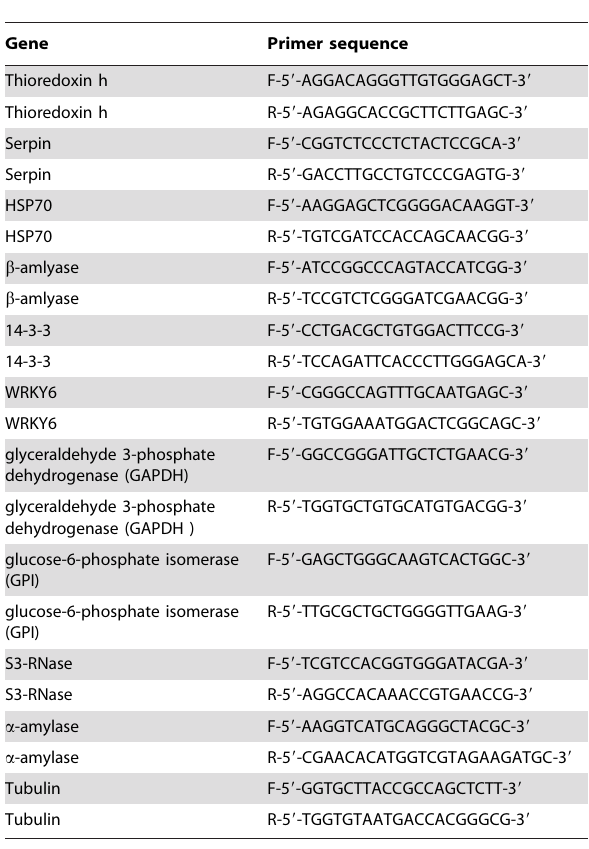
Table 1. Sequences of the primers used for real-time